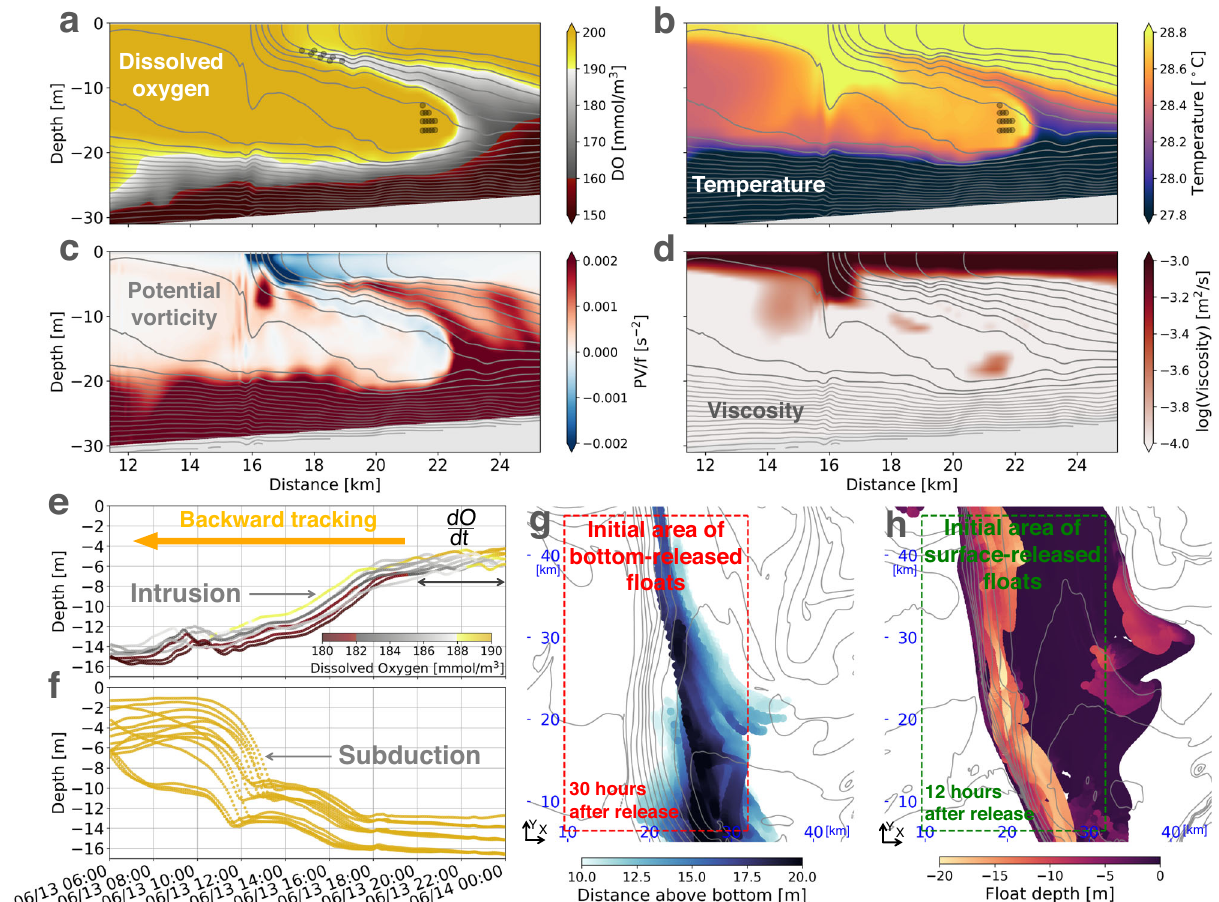
Fig. 4 | Slantwise vertical exchange at fronts. a – d Across-front sections of dis- solved oxygen, temperature, potential vorticity, and viscosity. The sections are made at June 14, 2010 00:00 UTC along the orange line marked in Fig. 3e. e Time series of fl oat depth colored by dissolved oxygen concentration. The fl oats are initiallyreleased atthe positionsmarked by the upper gray dots in a and backward tracked in time. The Lagrangian rate of change of oxygen near the surface is esti- mated as dO / dt ≈ 0.82 mg L − 1 day − 1 . This rate of oxygenation is obtained by